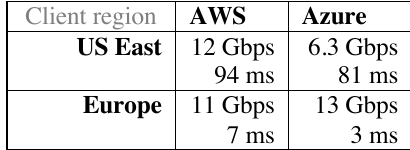
Table 4. Observed peak throughput while downloading data from OSG-operated xrootd services on PRP hardware into Cloud compute instances.